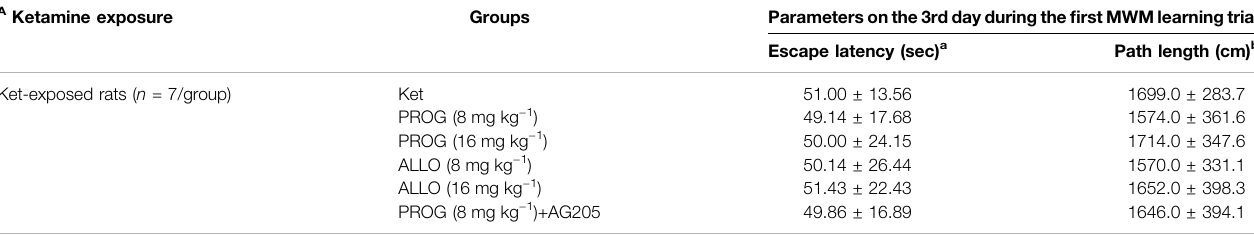
TABLE 2 | Performance of ketamine-treated rats randomly assigned to each group before add-on treatments (mean ±